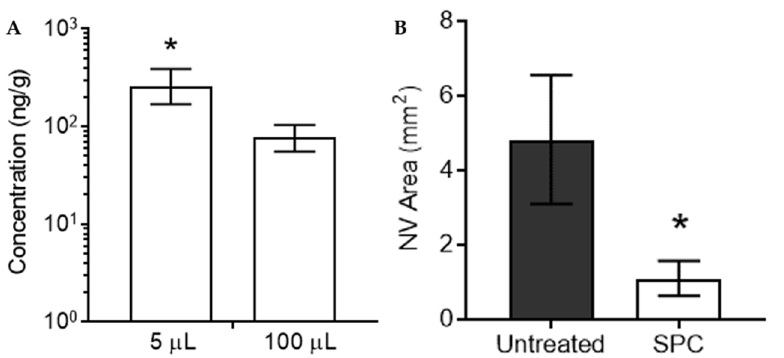
Figure 6. Subconjunctival SPC microcrystals suppress corneal neovascularization in a rat model. ( A ) A single unilateral subconjunctival injection of 100 µ g SPC microcrystals was given to rats in two different injection volumes (5 and 100 µ L). After 7 days, cornea tissues were collected and analyzed for combined levels of sunitinib and N -desethyl sunitinib ( n = 4–6). Units shown as ng combined drug per g of tissue (ng/g). Data shown as median ± IQR. * p < 0.05 ( B ) SPC microcrystals (100 µ g in 5 µ L) were injected unilaterally at the same time as suturing the cornea to induce neovascularization. SPC microcrystals suppressed neovascularization for up to 1 week compared to untreated control animals ( n = 4–8). Data shown as mean ± SD. * p < 0.05. Statistical analyses conducted by Student’s t-test.